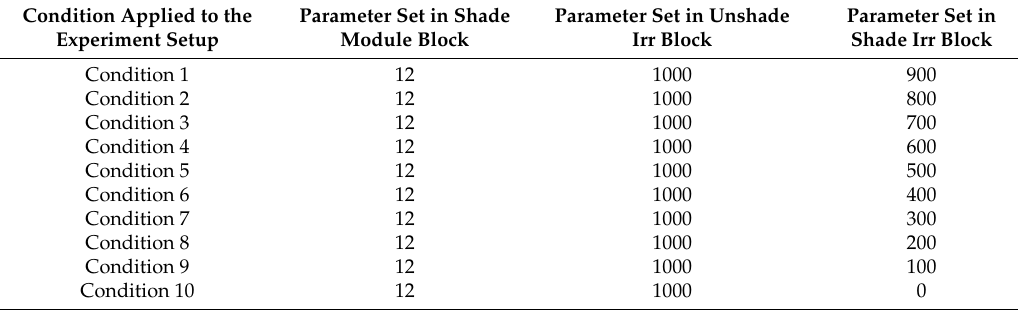
Table 4. Parameters set in the model shown in Figure 7 to conduct the experiment for the 12 modules shaded